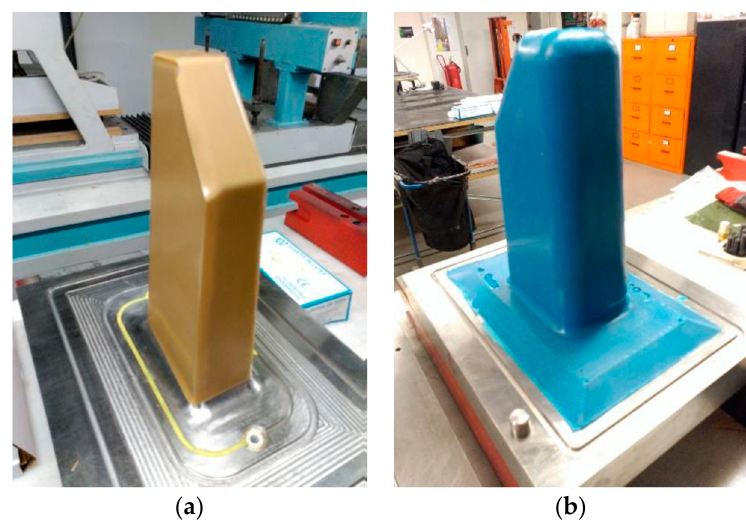
Figure 20. Silicone mould manufacturing. ( a ): Calibrated wax applied to the mould.; ( b ): Cured silicon rubber.